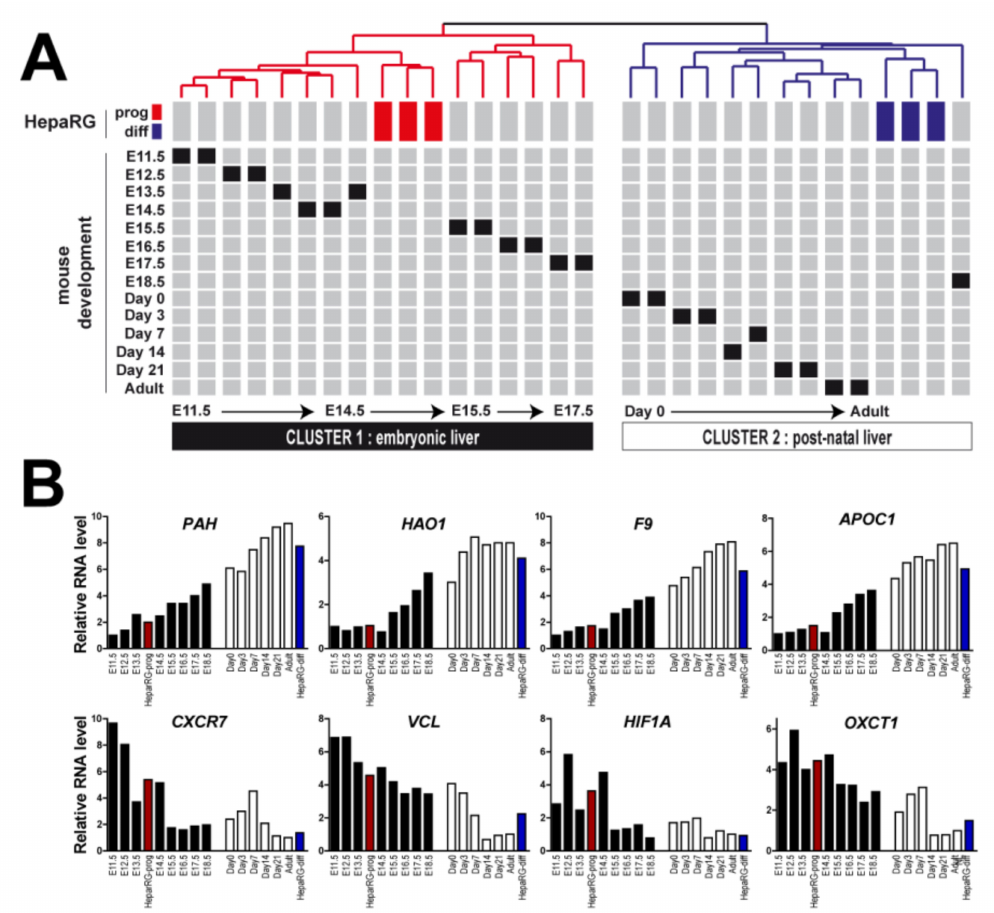
Figure 3. Differentiated and progenitor HepaRG gene profiles recapitulate relevant stages of mouse liver development. ( A ) Clustering of mouse and human samples based on the expression of orthologous genes identified from the signature of genes differentially expressed between differentiated and progenitor HepaRG cells. Data are presented in a matrix format in which rows and columns represent the position of each sample within the dendrogram. Mouse gene expression profiling was performed between E11.5 to adult stage. Clustering analysis identified two major clusters: cluster 1, which includes progenitor HepaRG cells (red boxes), is associated with embryonic mouse liver samples and cluster 2, which includes differentiated HepaRG cells (blues boxes), is associated with post-natal mouse liver samples. ( B ) Examples of the expression of developmentally regulated genes. Red bars: progenitor HepaRG cells; blue bars: differentiated HepaRG cells; black bars: embryonic stages in mice (from E11.5 to E18.5, left to right); white bars: post-natal stages in mice (from Day0 to adult stage, left to